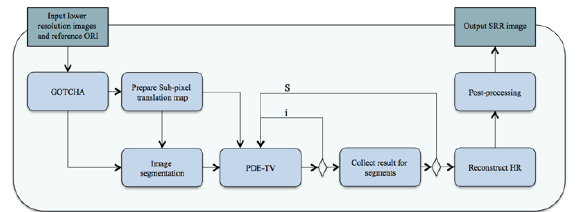
Figure 1 Flow diagram of GPT-SRR processing chain.